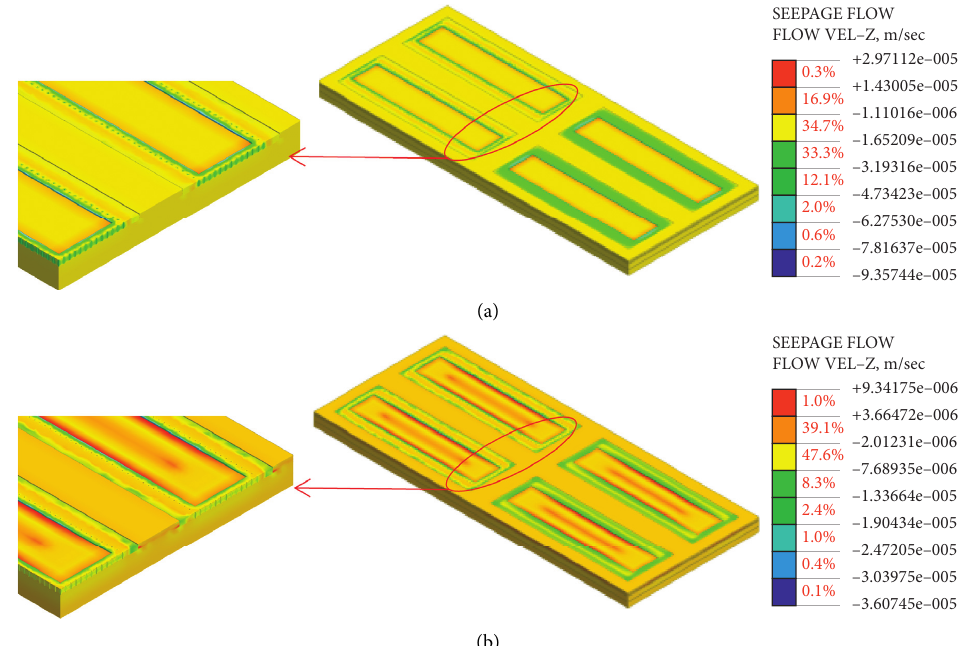
Figure 31: Infiltration velocity nephograms of buildings with seepage wells placed around buildings 1 and 2 after (a) 10min and (b) 120min of rainfall in the numerical model (the color of the legend represents the infiltration velocity range. The value of the legend represents the infiltration velocity value. The red % represents the volume percentage of color legend in the whole numerical